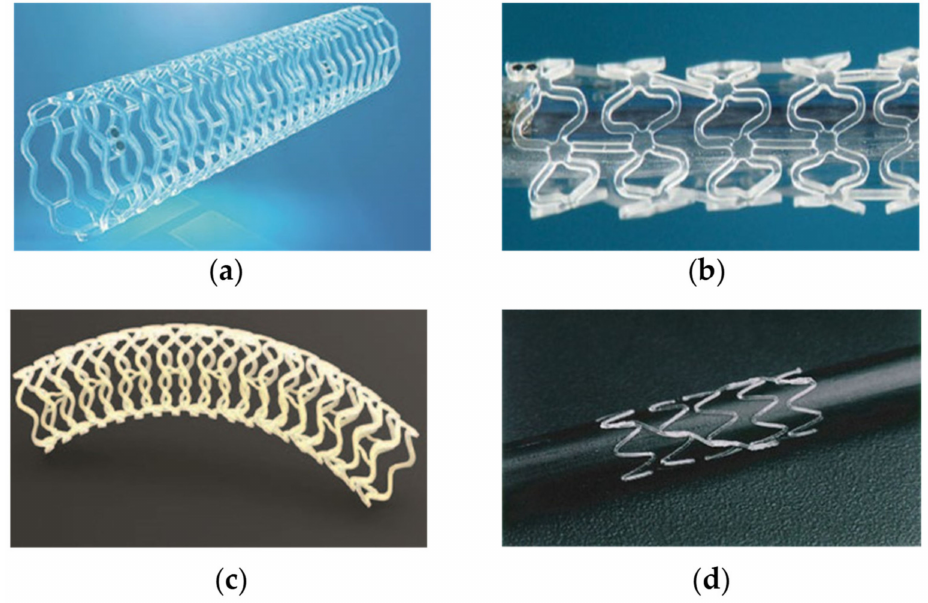
Figure 1. Bioresorbable stents: ( a ) Abbott ABSORB stent; ( b ) DESolve stent; ( c ) Fantom stent; ( d ) Igaki-Tamai